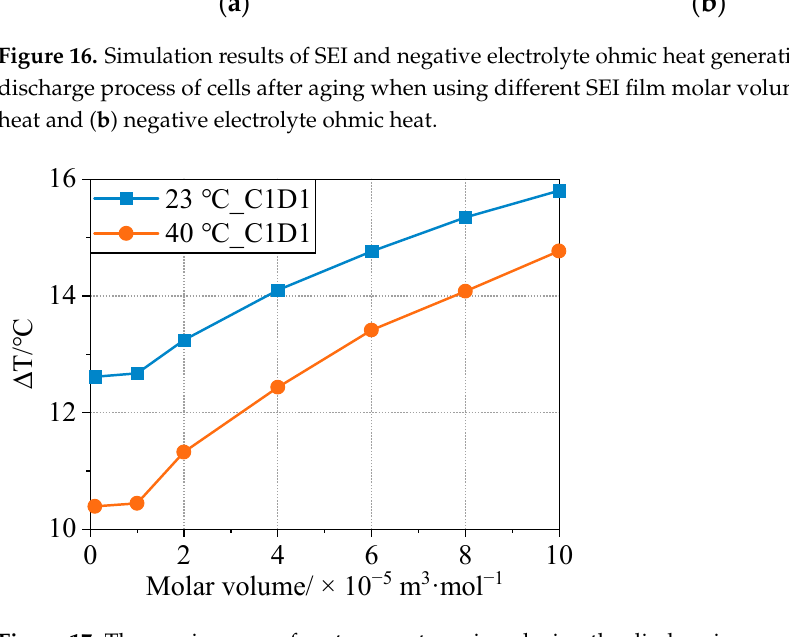
( b ) Figure 18. Comparison of the main heat generation items during the discharging process when the cell ages to EOL under different aging modes at ( a ) 23 °C and ( b ) 40 °C. Figure 19 demonstrates that when just the LLI occurs in a battery, the negative elec- trolyte ohmic heat and SEI heat are greater after aging because all the lost lithium ions are involved in the SEI growth reaction, the SEI is thicker, and the porosity declines more after aging. 0.0